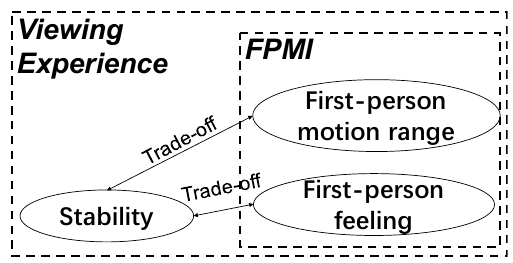
Figure 7. Properties of First-Person Motion.